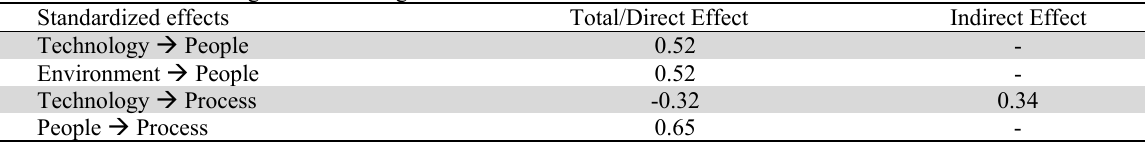
Standardized effects of exogenous on endogenous latent